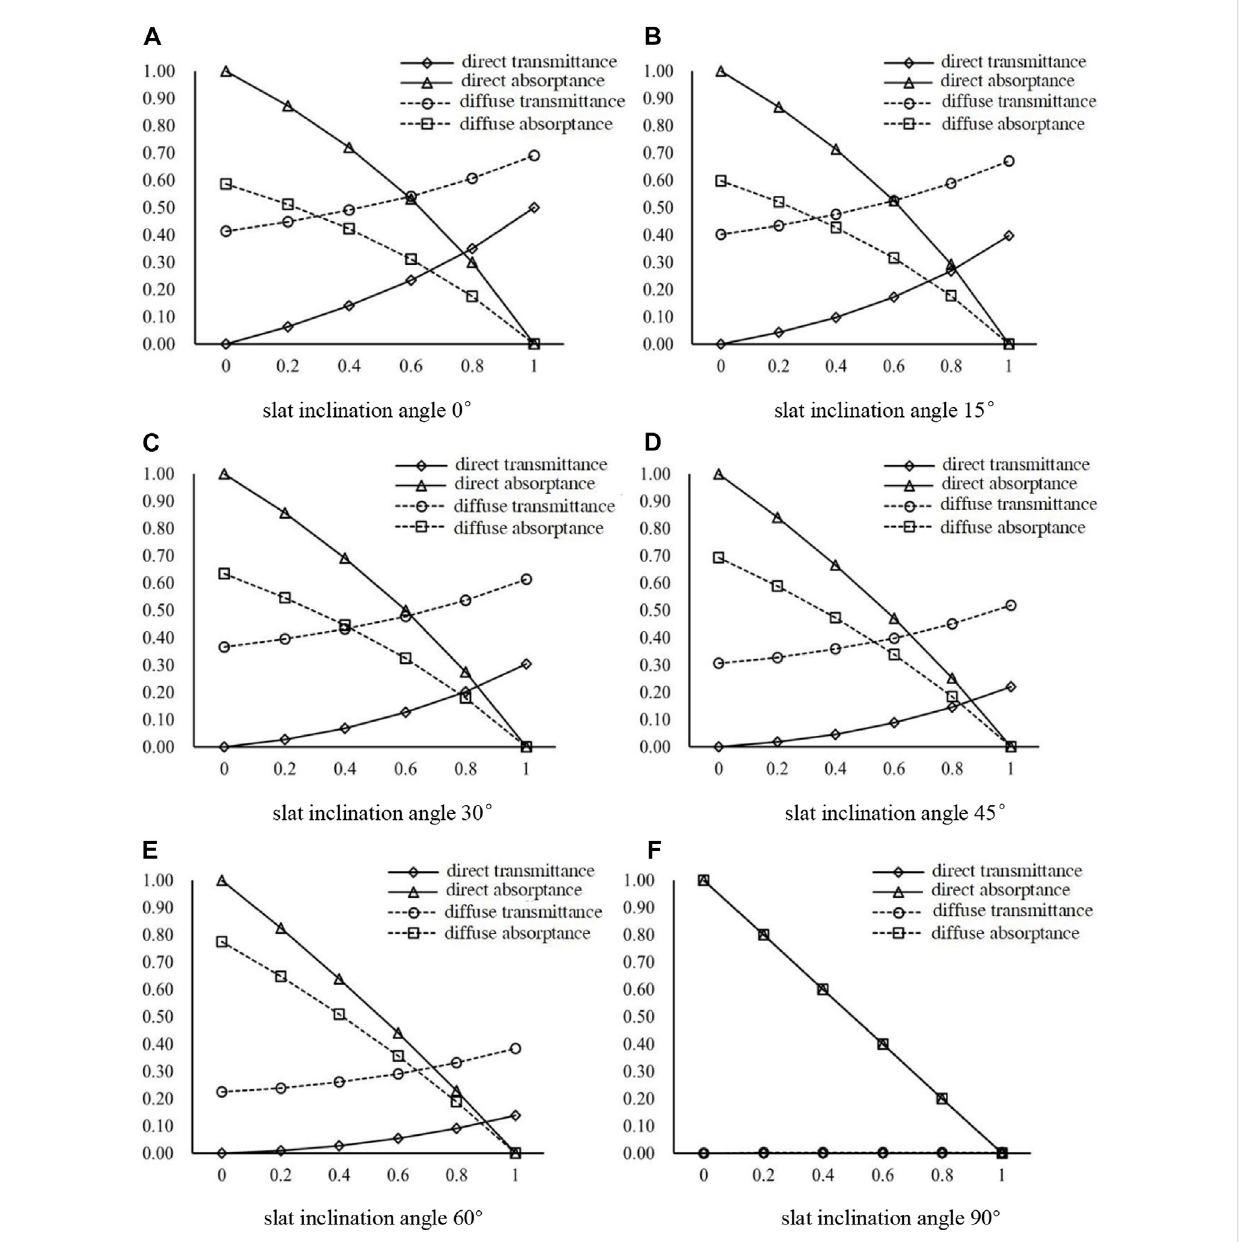
FIGURE 11 Effect of different slat materials on the optical performance of PCM blind. (A) slat inclination angle 0 ° (B) slat inclination angle 15 ° (C) slat inclination angle 30 ° (D) slat inclination angle 45 ° (E) slat inclination angle 60 ° (F) slat inclination angle 90 ° .